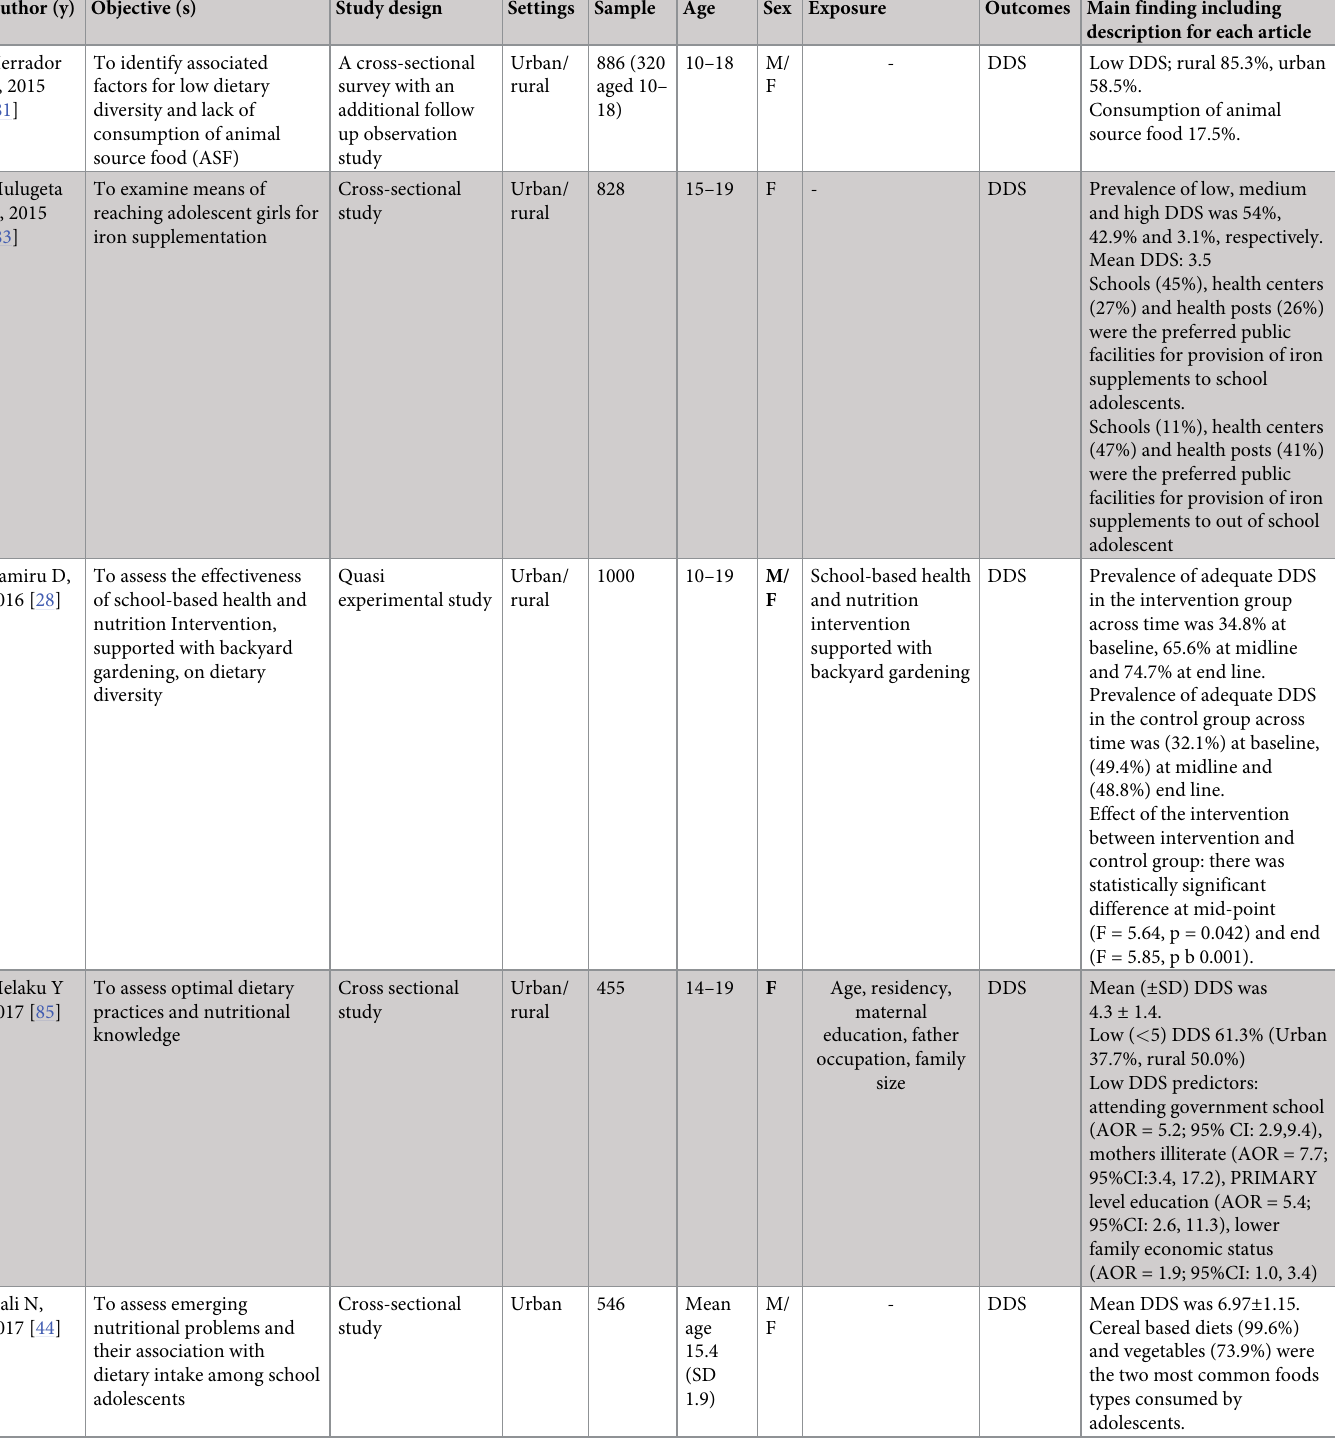
Table 3. Studies focusing on dietary diversity score